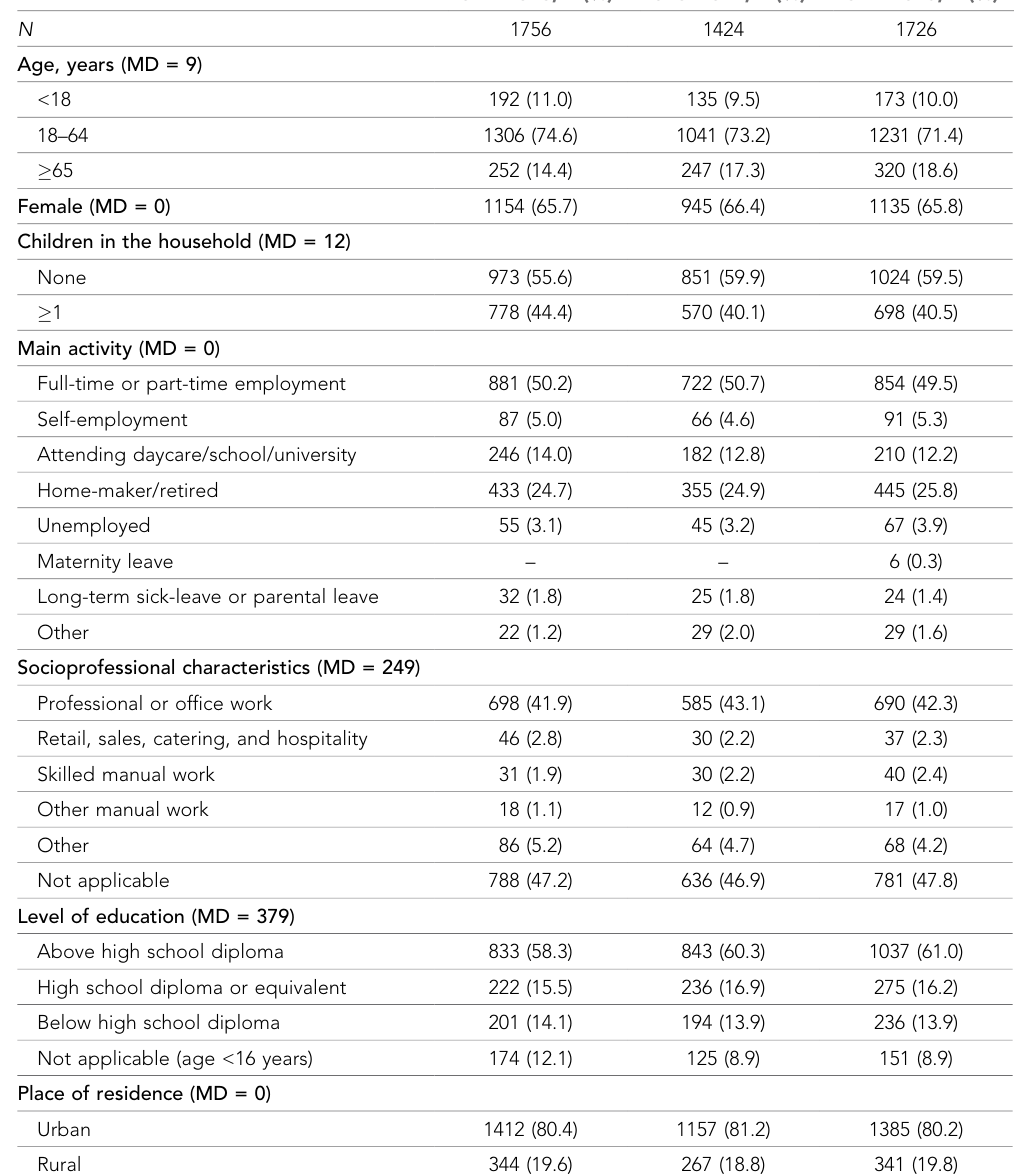
Table 1. Sociodemographic characteristics of individuals included in the study (an individual may have been involved in 1, 2, or 3